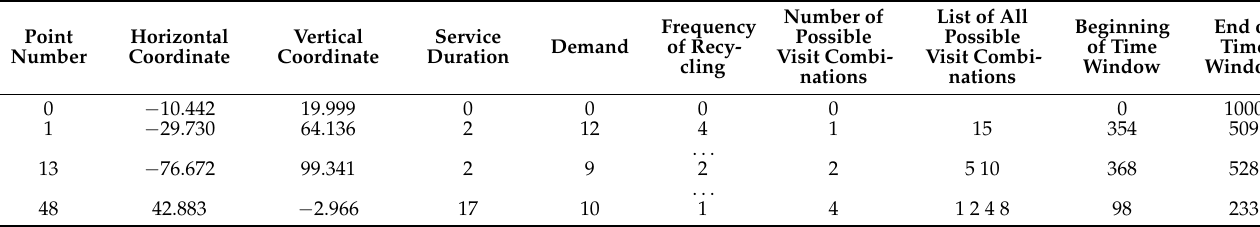
Table 3. The parameters of case